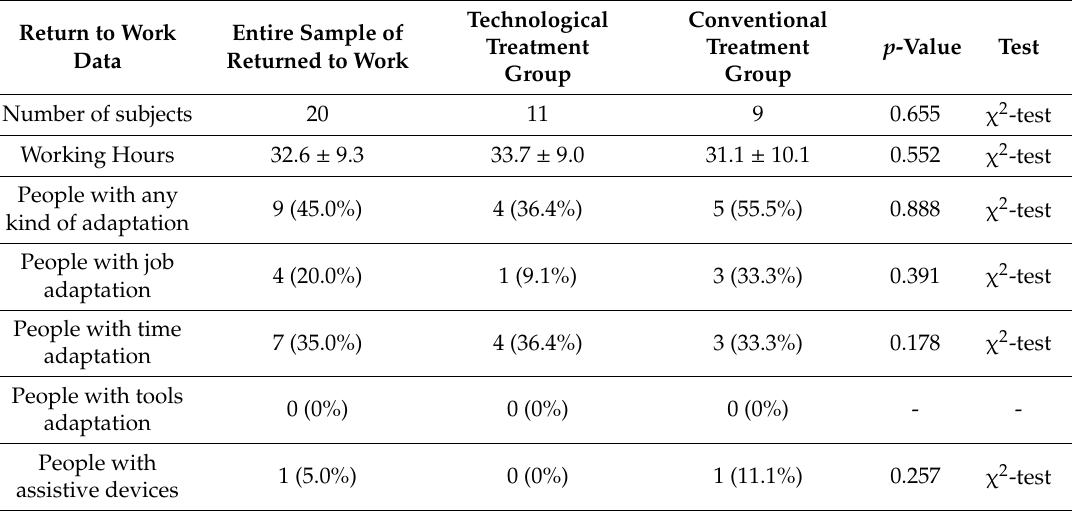
Table 3. Data of patients returned to work and comparison of TG and